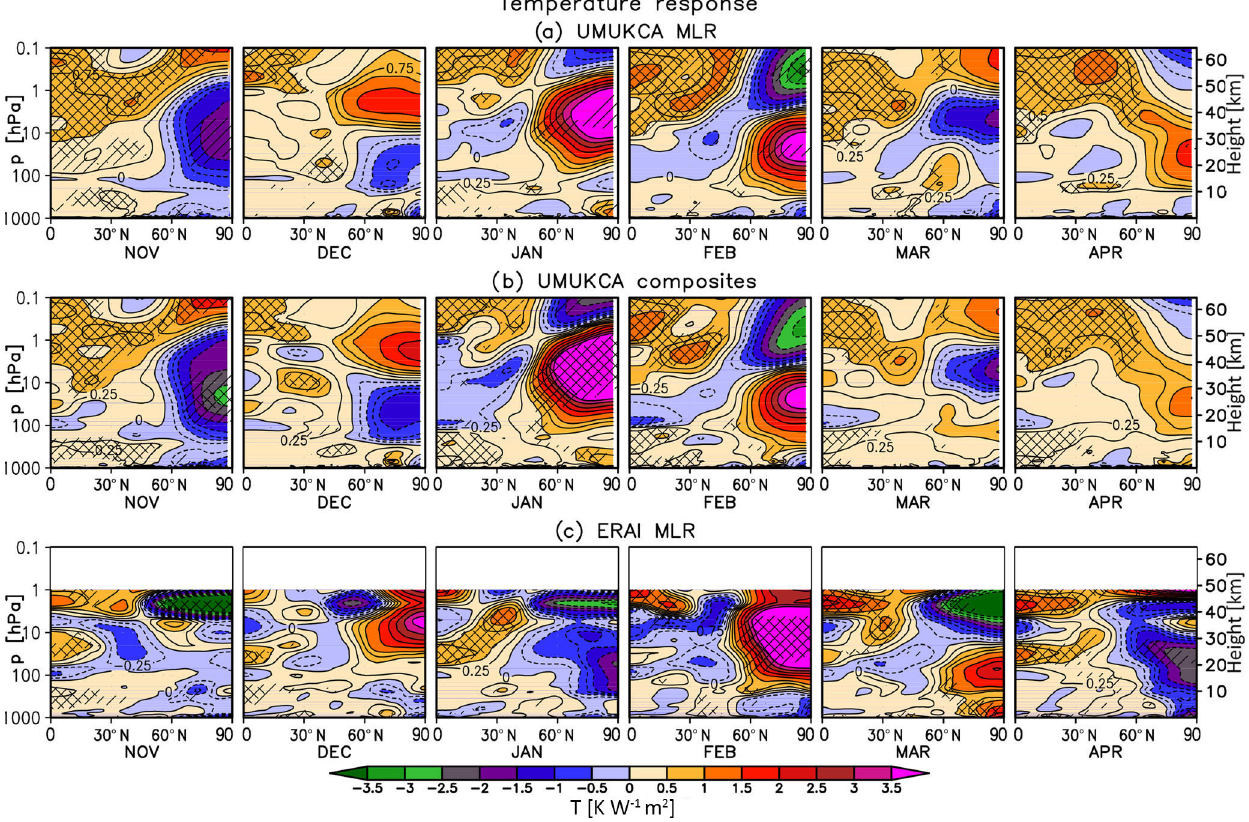
Figure 6. Monthly mean November–April zonal mean temperature response (KW − 1 m 2 ) in UM-UKCA derived using MLR (a) and com- posites (b) . Shown also is the ERAI response derived with MLR (c) . Single and double hatching indicates statistical significance on the 90% and 95% level, respectively ( t test). Note the additional contours at ± 0 . 25KW − 1 m 2